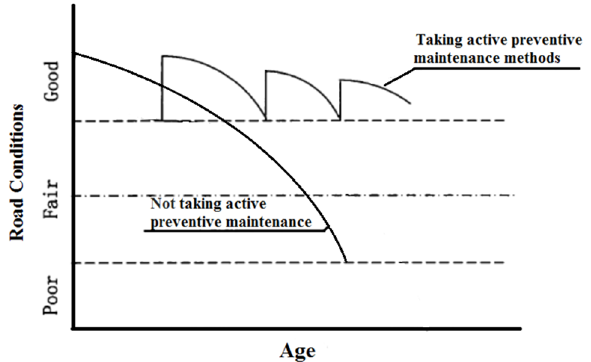
Figure 1. Road conditions under taking/not taking pre ‐ maintenance work.